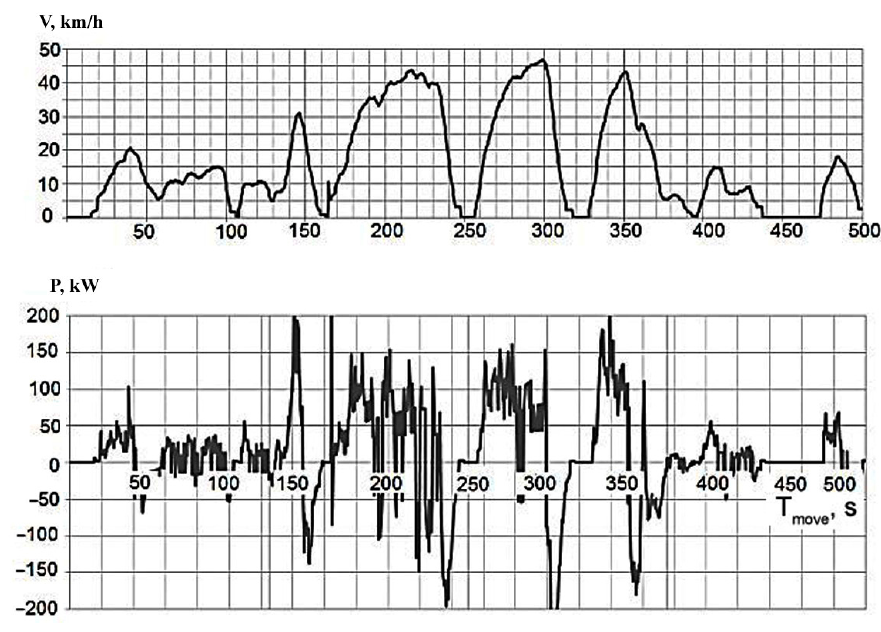
Figure 19. Battery overvoltage protection model.